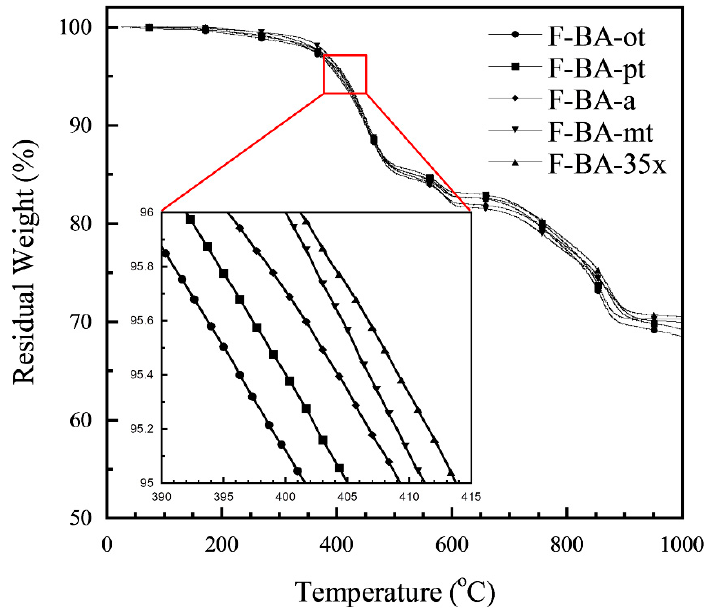
Figure 3. TGA thermogram of polybenzoxazine composites prepared from different benzoxazine resins. Table 3. Thermal stability obtained from the TGA of polybenzoxazine composites.